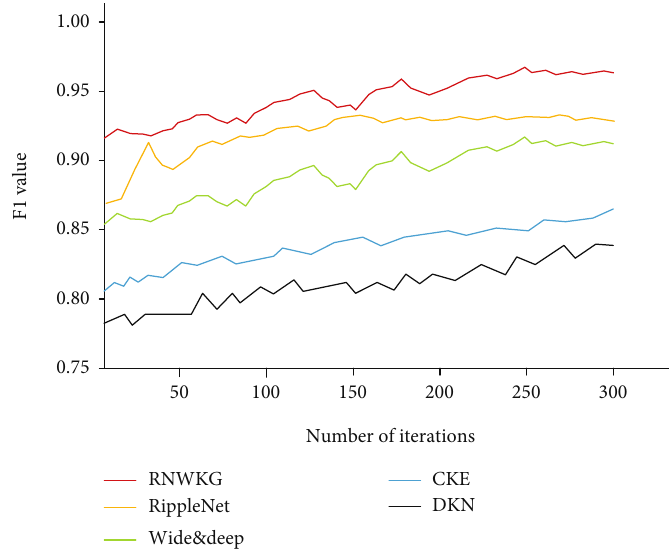
Figure 9: Comparison of F 1 values of fi ve models in Book-Crossing.